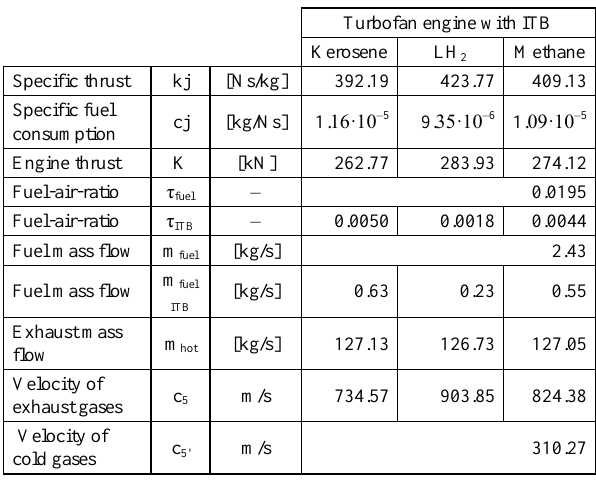
Table 4. Results of thermodynamics analysis of modified turbofan engine configuration